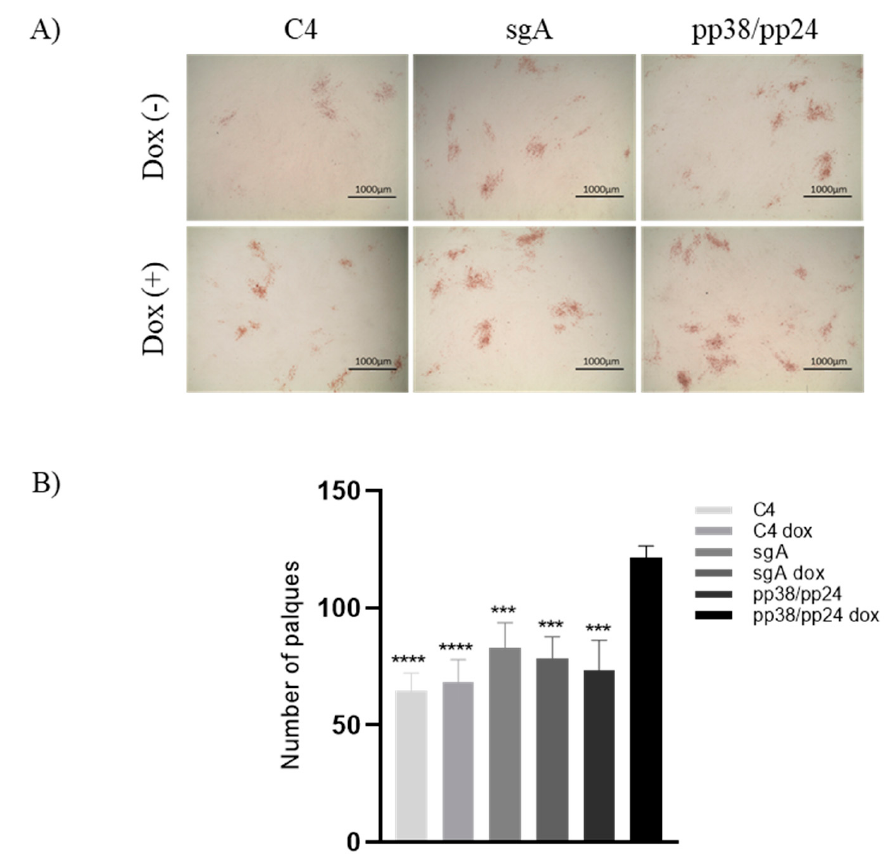
Figure 4. MDV reactivation was enhanced with pp38/pp24 overexpression. ( A ) C4 cells were transfected with gRNAs. At 24 h pt, 1 × 10 4 C4 cells were co-cultivated with CEFs in 24-well culture plate. At 5 days post co-cultivation, the plaques were labelled with gB mAb (HB3) and anti-mouse HRP conjugate. The stained plaques were captured using the EVOS digital microscope (Thermo Fisher Scientific, Waltham, MA, USA) at 20x magnification. The scale bar, 1000 µm. ( B ) A histogram representing the average number of plaques formed from duplicates of each sample. Asterisk indicates statistically significant differences between pp38/pp24-overexpressing cells and each of the control cells. ***, p < 0.001; ****, p < 0.0001.